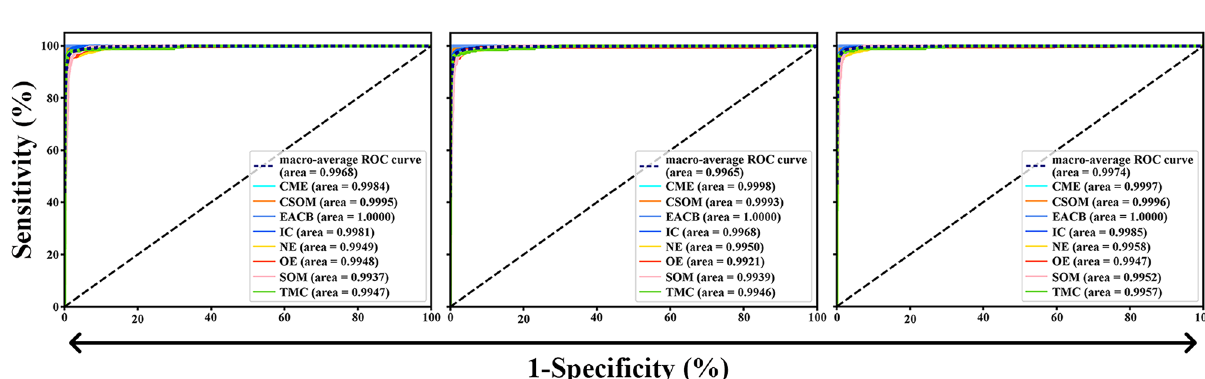
Figure 8. The sensitivity–specificity curve of the ensemble classifier at the test sample sets for Urgent versus Non-urgent binary